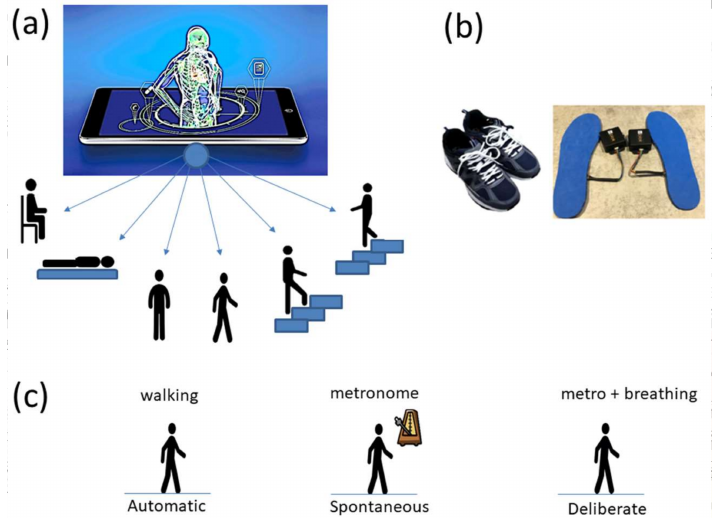
Figure 2. Experimental conditions. ( a ) The Kaggle activity recognition set includes 6 activities recorded using accelerometers and gyroscopes embedded in a smart phone (sitting, laying, standing, walking, walking upstairs and walking downstairs). ( b ) The Sensory Motor Integration Lab (SMIL) data set includes gait patterns collected with Zeblok smart shoes containing inertial measurement units and pressure sensors employed to measure natural walking. ( c ) Further variations on natural walking are used to assess sensitivity of the insole sensors and to profile levels of neuro-motor control across automatic, spontaneous and deliberate